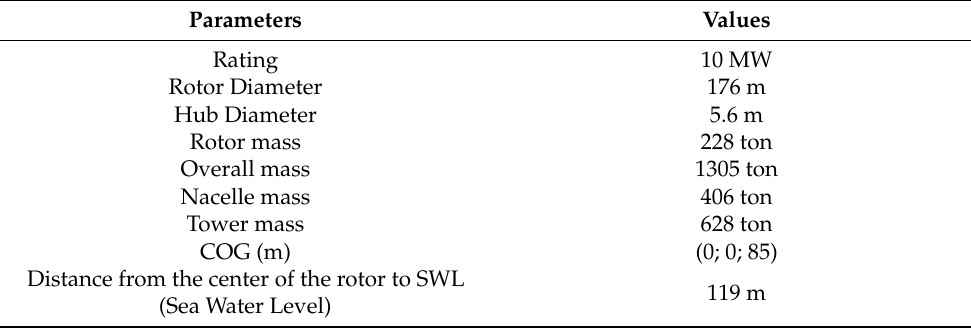
Table 1. DTU 10 MW wind turbine main parameters.